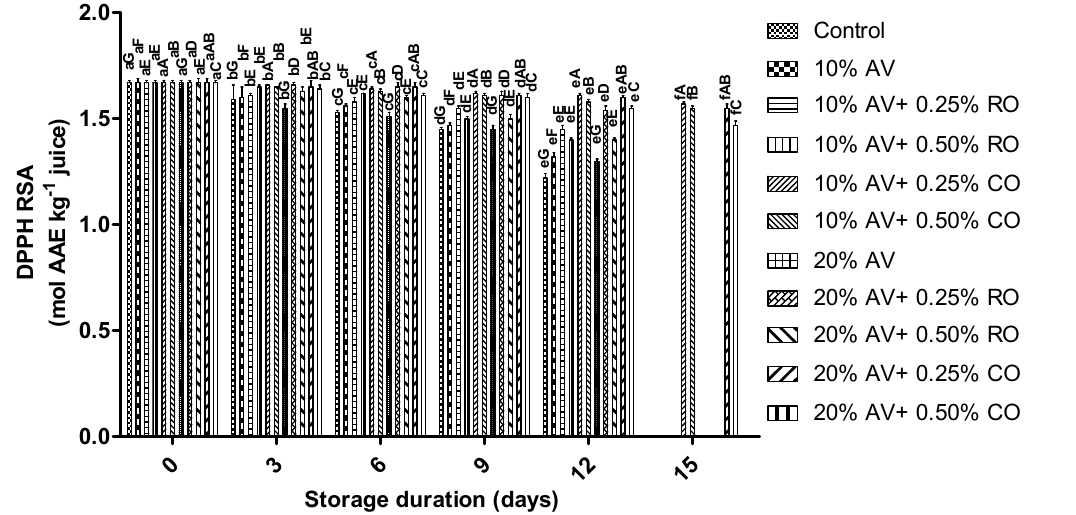
Figure 8. DPPH RSA (mol AAE kg − 1 juice) of ‘Bhagwa’ pomegranate arils that were coated with Aloe vera (AV) gel coatings that were enriched with rosehip oil (RO) (0.25% or 0.50%) and cinnamon oil (CO) (0.25% or 0.50%) and stored at 5 ± 1 °C (95 ± 2% RH) for 15 days. The vertical bars represent the standard deviation (SD) of the mean values of three replicates (1 punnet = 1 replicate, n = 3). Values bearing at least one common small superscript (a,b,…, etc.) and at least one common capital superscript (A,B,…., etc.) letters differ significantly between the days and between the coating solution/concentrations, respectively, at p < 0.05 in Duncan’s multiple comparison post hoc test.